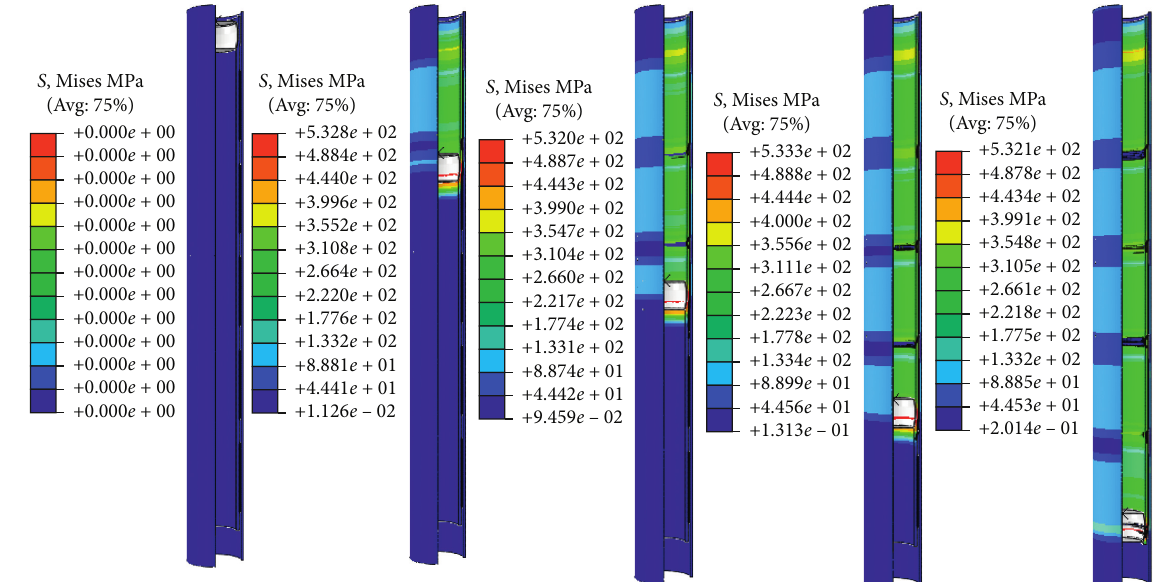
Figure 9: Cloud diagram of equivalent stress generated on the hanger body during the expansion.